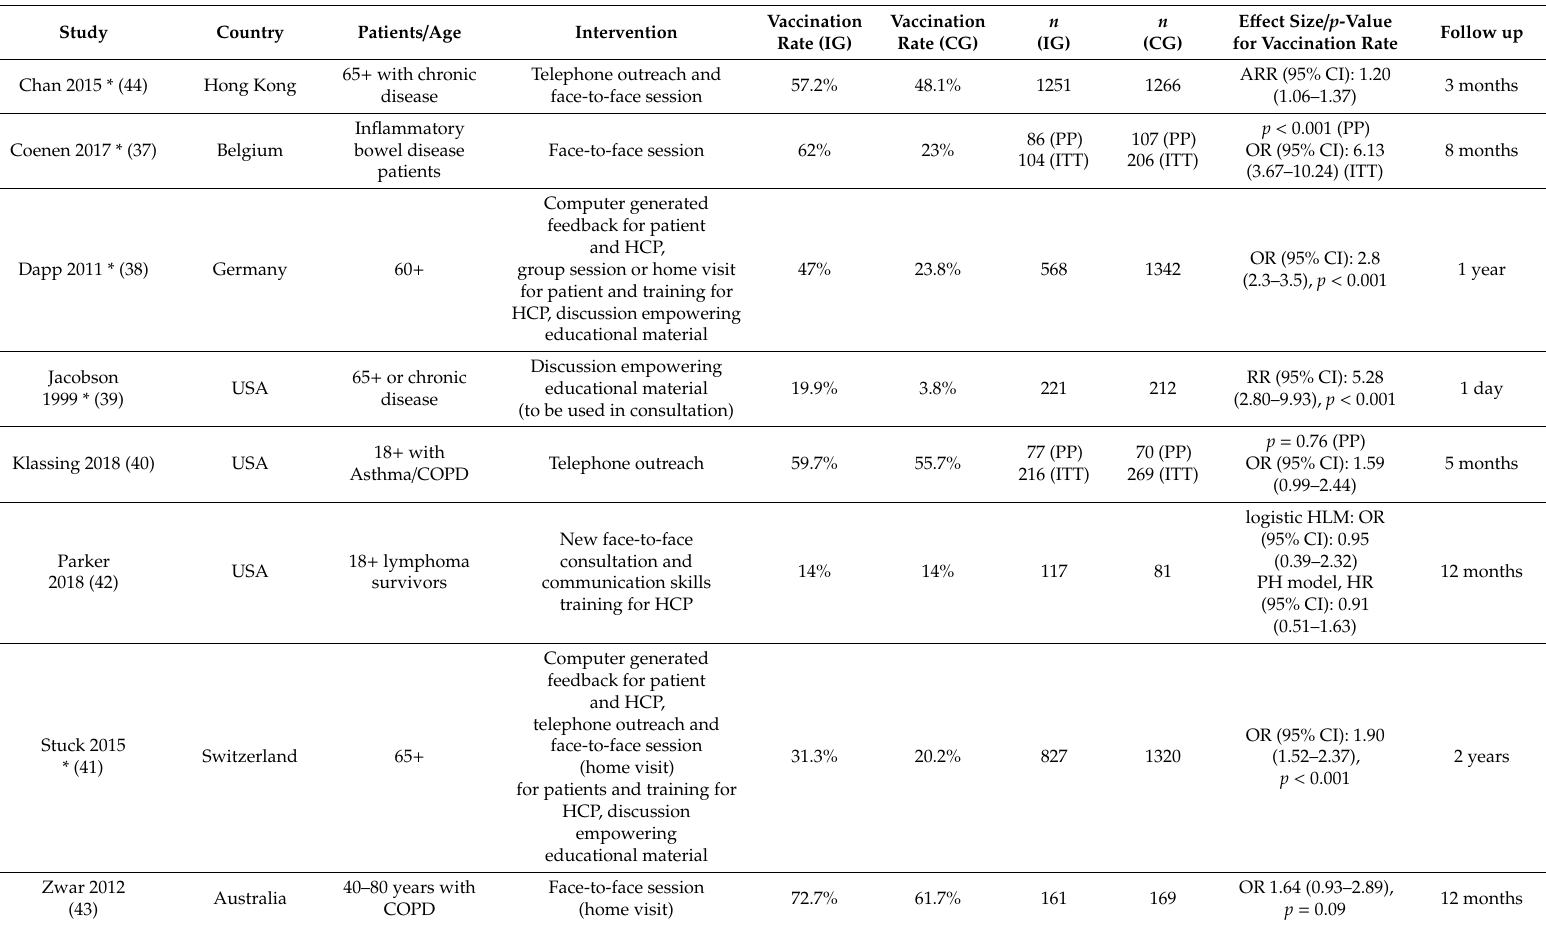
Table 1. Characteristics of included